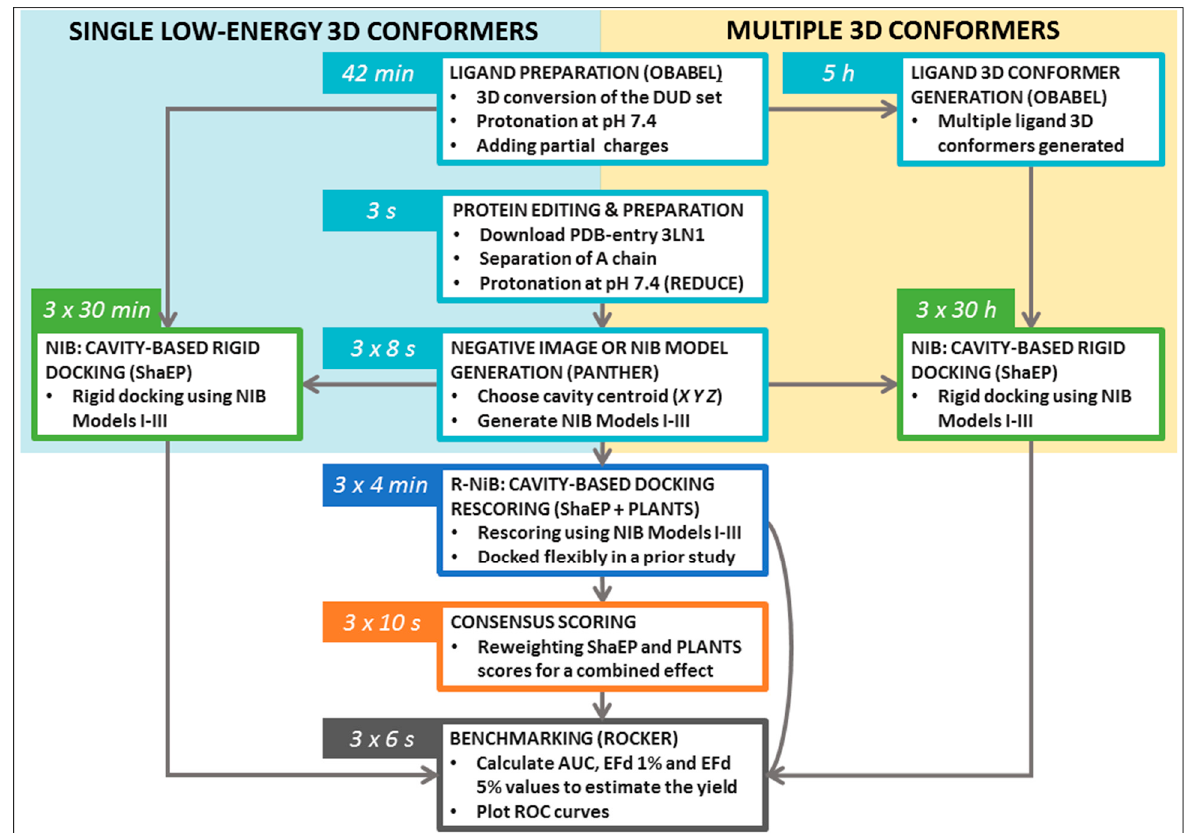
Figure 3. The duration of the protocol steps for the benchmarking example. The negative image-based (NIB; Figure 1) [1] screening or rigid docking can be done either using single low-energy conformers (Table 2) or using multiple conformers (Table 3). Going through the negative image-based rescoring (R-NiB; Figure 2) [16] protocol takes considerably less time (Table 4) because it is done using explicit PLANTS docking poses taken from a prior study [16]. Moreover, the rescoring process does not require geometry optimization in addition to the shape / charge similarity comparison. The execution of the NIB and R-NiB protocols with the cyclooxygenase-2 (COX-2) DUD test set can take less or more time depending on the used computer set-up. For simplicity, all the steps in the workflow are done using a single processor, but the process, especially the NIB screening with multiple ligand 3D conformers, can be sped up substantially by dividing the ligand sets into separate batches that are processed separately. 2.1. Ligand Preparation: 3D Conversion, Protonation, and Partial Charges In the NIB screening (Figure 1), the rigidly docked ligand 3D conformers are generated ab initio with a separate software (Table 1); however, depending on the target protein and the ligand sets one can acquire high enrichment using only a few or even a single low-energy conformer. Before performing the cavity-based rigid docking with a single conformer or multiple conformers, the 3D coordinates (simplified molecular-input line-entry system (SMILES)-to-MOL2), partial charges and ionization/protonation states of the small-molecules need to be generated (Figure 1). This is achieved using, for example, LIGPREP in MAESTRO or MARVIN, but non-commercial software such as RDKit or OBABEL [21] can also be used. It is crucial that the pH is set to match the conditions of the activity assay (e.g., pH 7.4) during the protonation. The DUD [19] ligands for COX-2 were converted from the SMILES format into the MOL2 format using OBABEL [21] (command #1). A single 3D conformer was generated for each ligand included in the set. Next, the protonation of the ligands was set to match pH 7.4 (command #2), and the partial charges were inserted using the Merck Molecular Force Field 94 (MMFF94) [22] (command #3) with OBABEL [21]. For comparison, the ligands were also prepped using LIGPREP in MAESTRO,